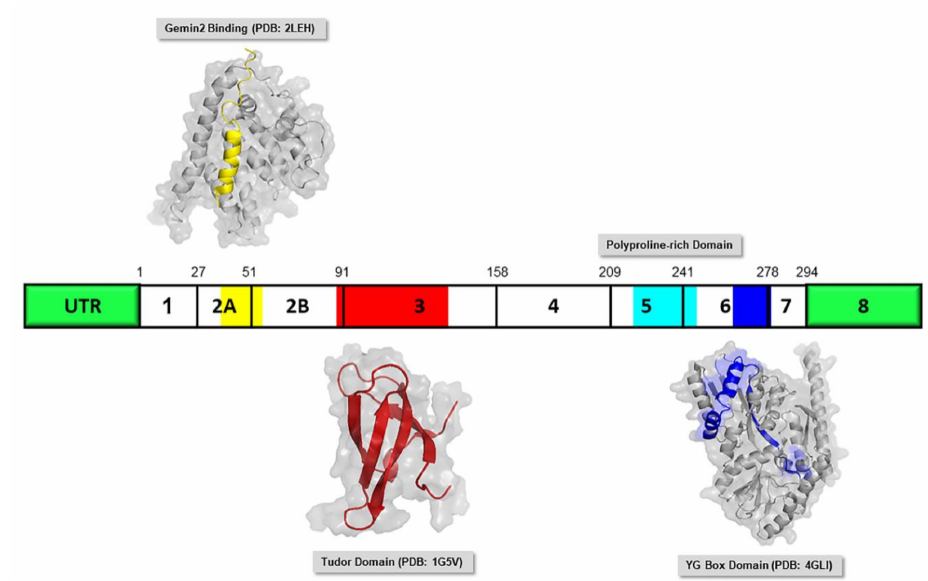
Figure 4. Diagrammatic representation of the full length SMN (FL-SMN) protein with its respective available protein structure. The number of exons is indicated within the boxes of SMN protein diagram with the number of the last amino acid residue of each exon, indicated above. The PDB structure of the domains are illustrated in the same color that overlaid in the SMN protein diagram indicating the location of the respective domains (Gemin2 Binding: yellow; Tudor Domain: red; Polyproline-rich Domain: cyan; YG Box Domain: blue). Abbreviation: UTR, untranslated